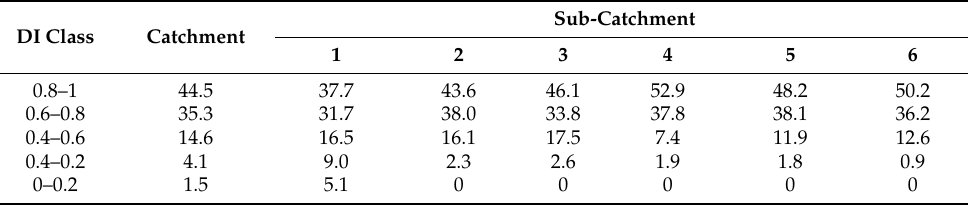
Table 5. Percentage (%) of total area of the catchment and of sub-catchments 1–6 falling within different distance indicator (DI)